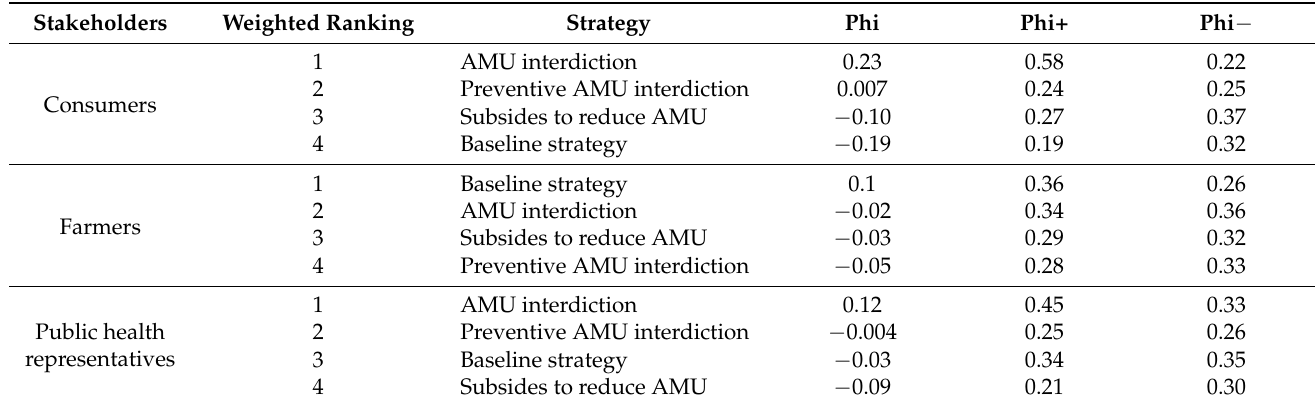
Table 1. Acceptability ranking scores of strategies to reduce antimicrobial use in French dairy farms by stakeholder